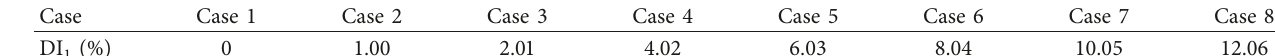
Figure 5: Partial damage in model tests (single damage). (a) Case 1. (b) Case 3. (c) Case 6. (d) Case 8. Table 3: Damage cases in model tests (single